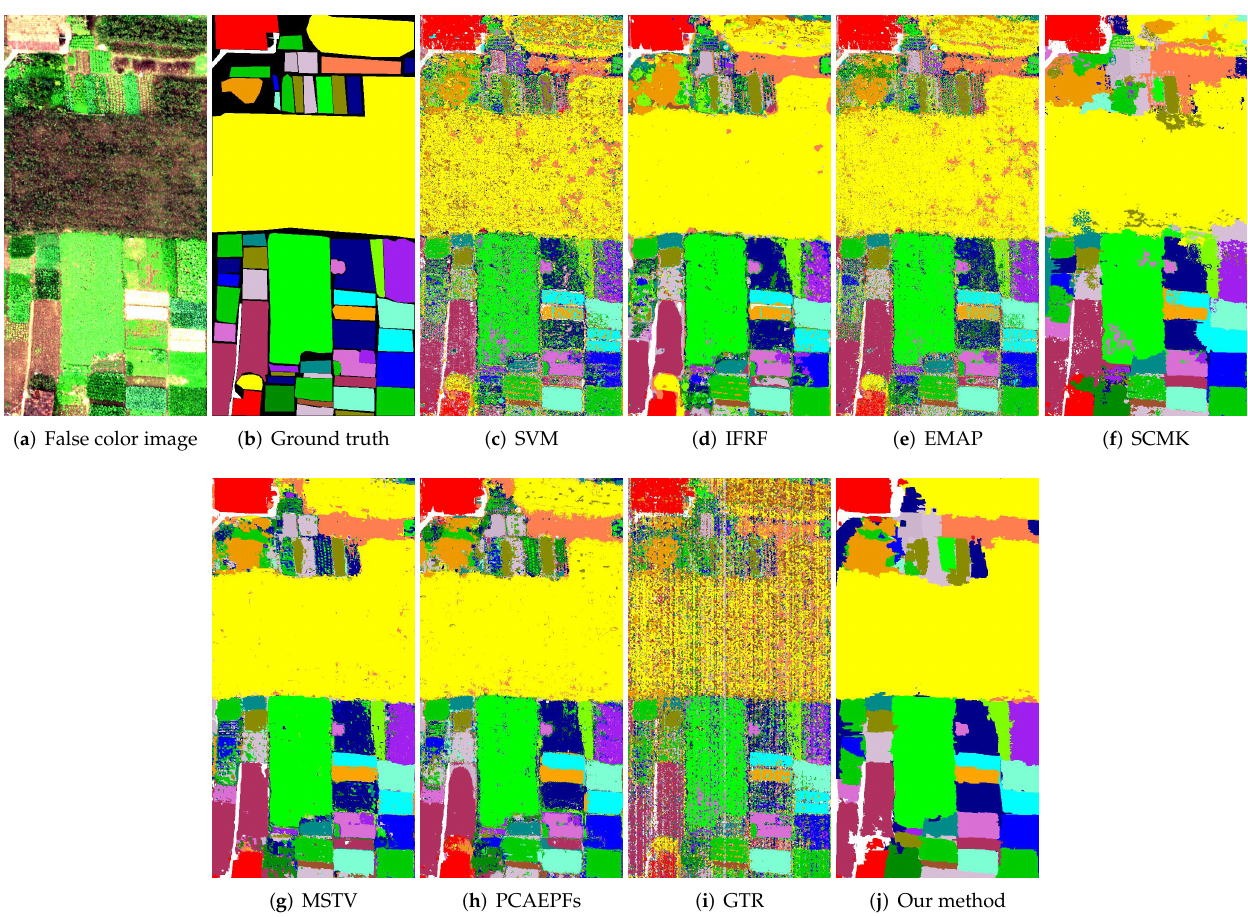
Figure 9. Classification results of all considered approaches on Honghu dataset. ( a ) False color image. ( b ) Ground truth. ( c ) SVM [33], OA = 64.43%. ( d ) IFRF [14], OA = 84.23%. ( e ) EMAP [13], OA = 76.11%. ( f ) SCMK [39], OA = 86.41%. ( g ) MSTV [15], 90.74%. ( h ) PCAEPFs [8], OA = 87.37%. ( i ) GTR [40], OA = 51.87%. ( j ) Our method, OA =